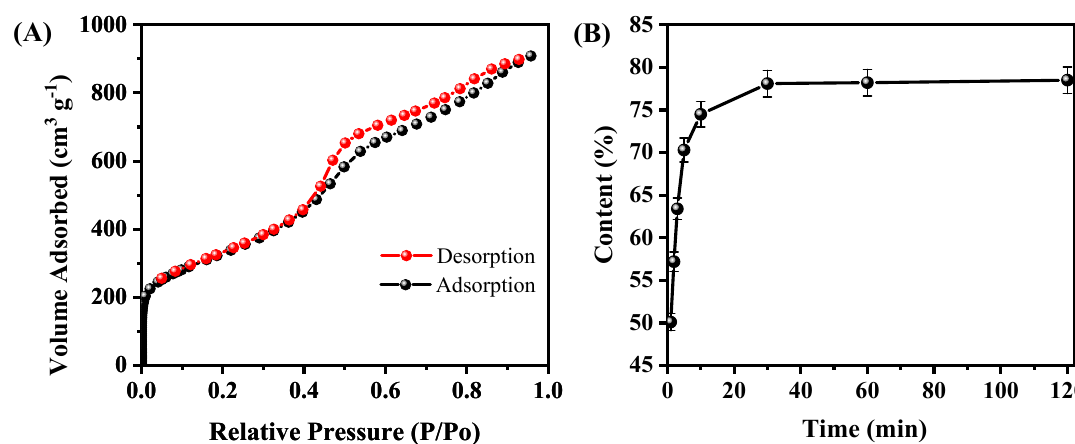
Figure 4. N 2 adsorption/desorption isotherms of A-CMK-3 ( A ) and absorbability of A-CMK-3 with different impregnating time ( B ).